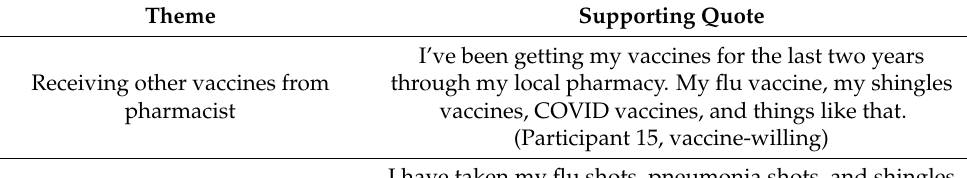
Table 5. Participants’ willingness to vaccinate with